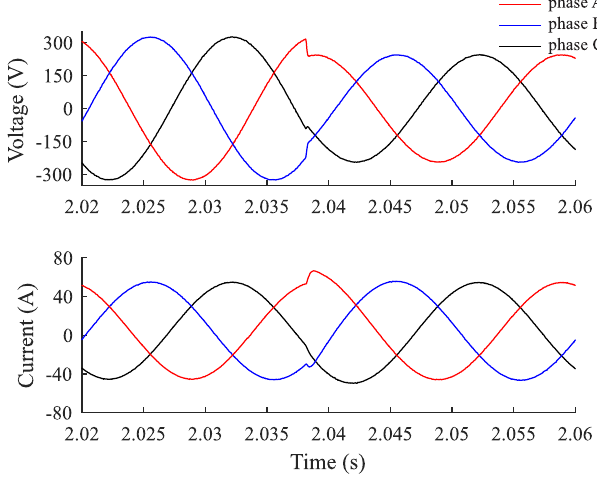
Figure 9. AC waveforms during a sudden symmetrical voltage dip of 25 percent with well-designed current